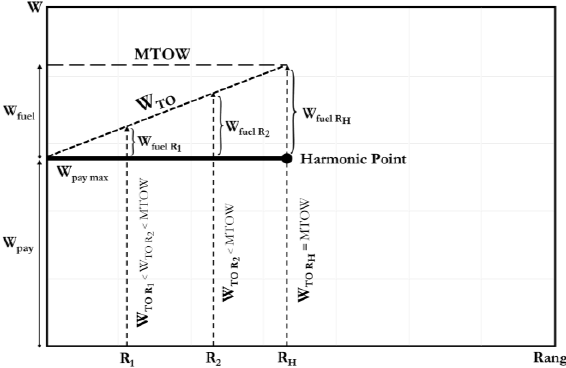
Figure 14. Payload – range diagram for aircraft with thermal propulsion — Part 1. Figure 14. Payload–range diagram for aircraft with thermal propulsion—Part 1.